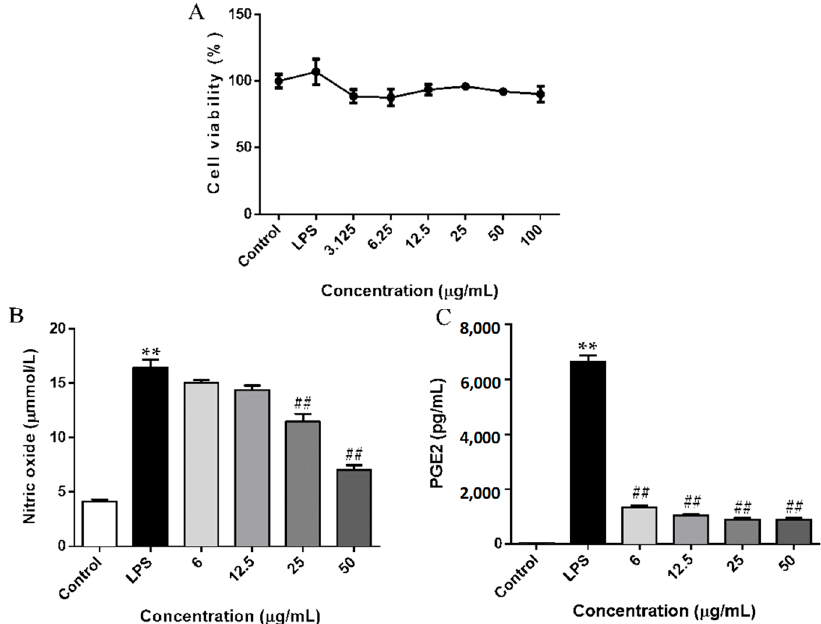
Figure 2. Effect of SCL on NO and PGE2 production in LPS-stimulated RAW264.7 cells. Cells were treated with SCL at various concentrations (3.125, 6.25, 12.5, 25 and 50 µ g/mL) for 1 h, and then stimulated with or without LPS for 24 h, cell viability was analysed with an MTT method. ( A ). The cells were incubated with indicated concentrations of SCL for 1 h, and then stimulated with LPS for 24 h. The concentration of NO (expressed as nitrite) and PGE2 in the culture medium were quantified by Griess reaction and ELISA, respectively ( B , C ). The data presented in bar charts are mean ± standard error of the mean (SEM) values from 4 independent experiments. ** p < 0.01 vs. unstimulated cells. ## p < 0.01 vs. LPS-stimulated cells.